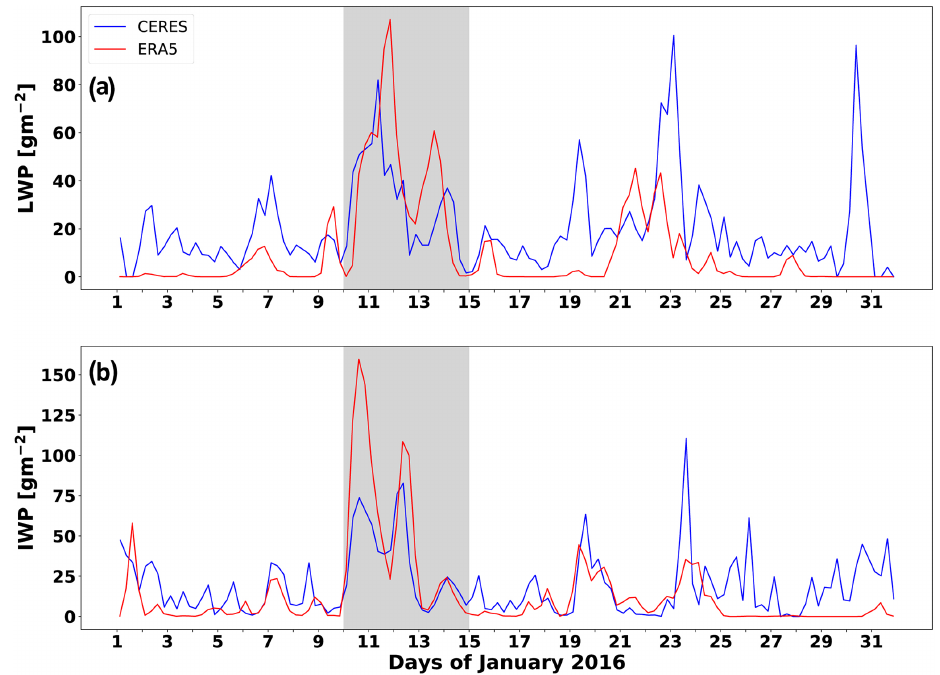
Figure A2. Time series of hourly cloud LWP (a) and IWP (b) from the CERES SYN1deg data product (red) and ERA5 (blue), over the Siple Dome region throughout January 2016. The shaded region denotes the time period of the WAIS large-scale melt event (Nicolas et al.